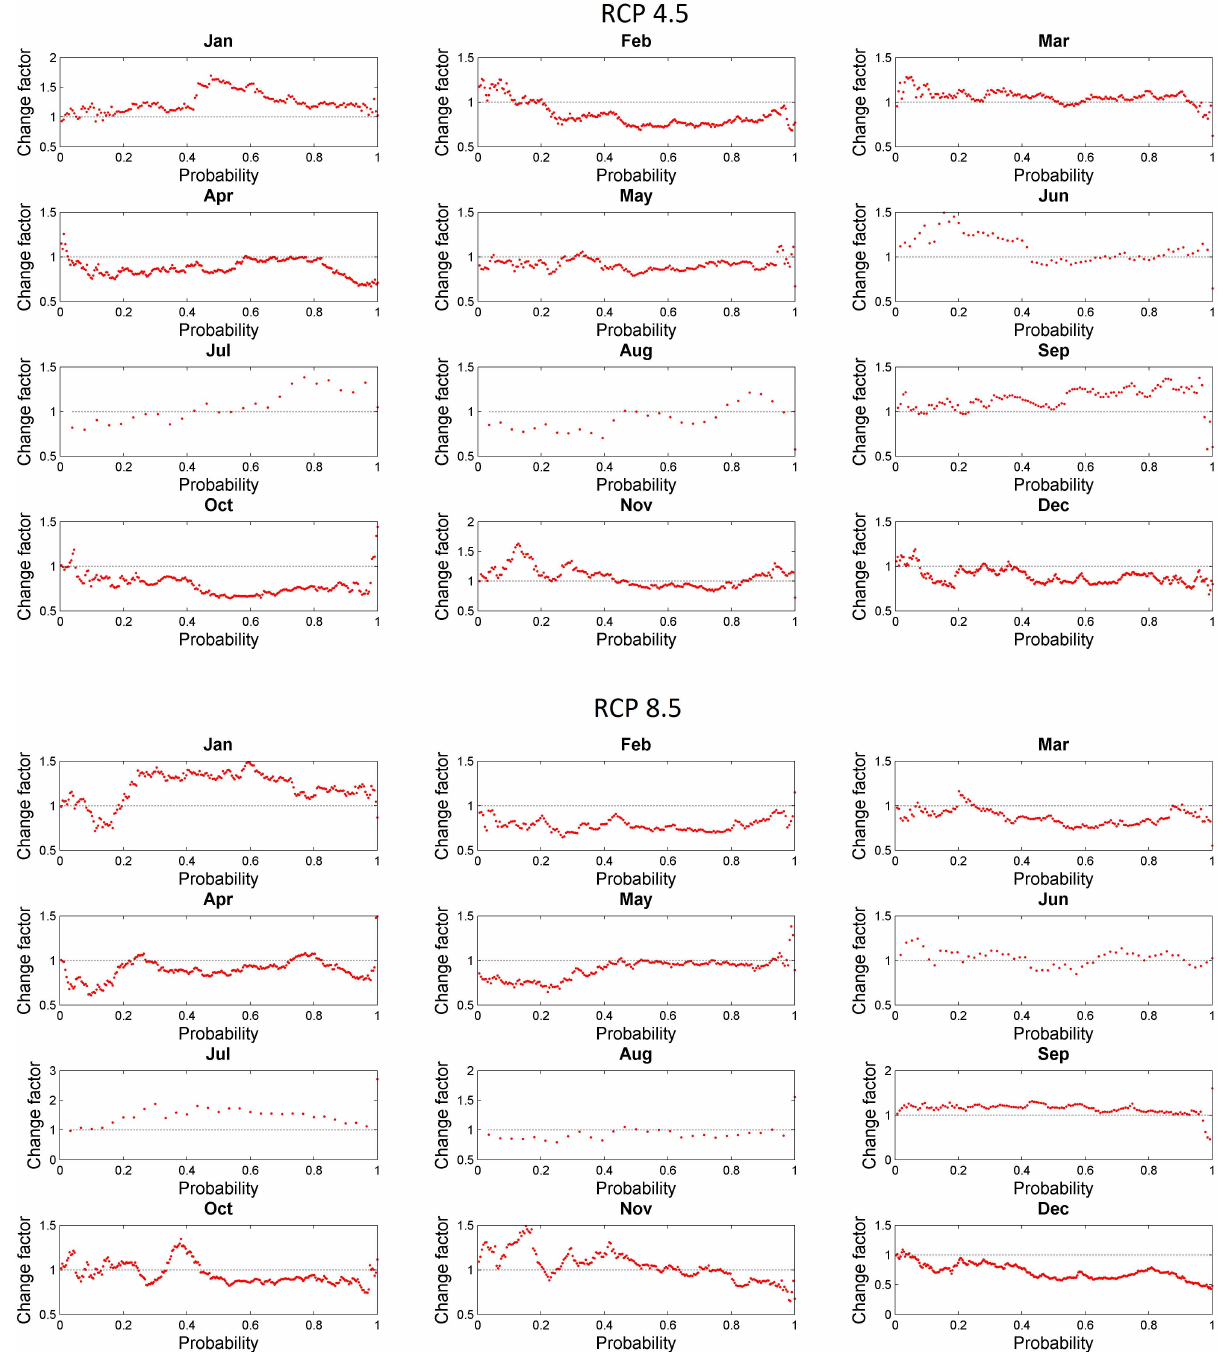
Fig. 13. Change factors on daily precipitation quantiles obtained each month between MED11-HIST and MED11-RCP4.5 (top panel), MED11-HIST and MED11-RCP8.5 (bottom panel). The historical period is 1984–2005 and the projection period is